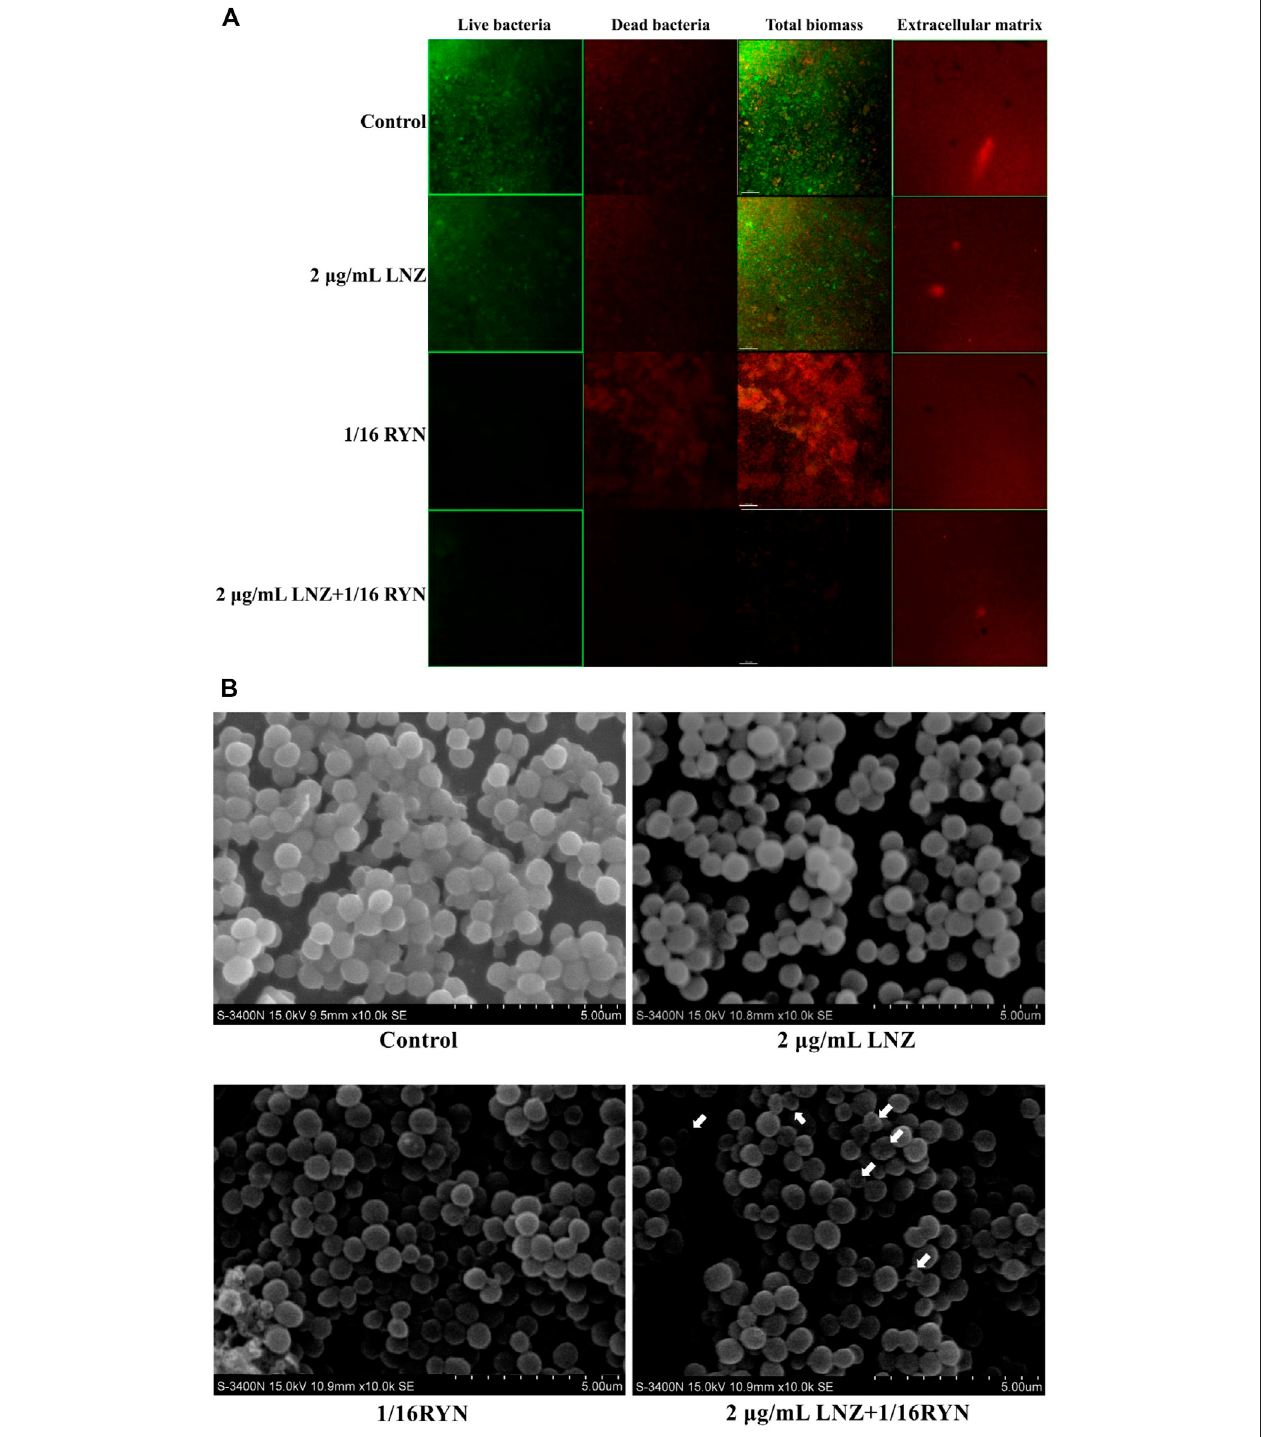
FIGURE 2 | Imaging results of the effects of LNZ and RYN on MRSA bio fi lm live and dead bacteria and extracellular matrix. (A) CLSM. In the fi rst three columns, green is the fl uorescence signal of living bacteria, and red is the fl uorescence signal of dead bacteria. The images show the inhibitory effect of LNZ and RYN on the maturity of MRSA bio fi lms, which is consistent with the results of the bio fi lm assay, and the combined group had a strong inhibitory effect on bio fi lms. There was no signi fi cant difference among the four groups in the extracellular matrix of the fourth column. The scale bar in images represents 150 µm. (B) SEM. In the mature stage ofaMRSAbio fi lmswithoutdrugintervention(control group), MRSAgrewinclumpsand thestructure ofthecellarrangementwascompact.Inthemature stageof MRSA bio fi lms treated with 2 μ g/ml LNZ and 1/16RYN, the structure of the cell arrangement was slightly loose. Combined 2 μ g/ml LNZ+1/16RYN intervention in the mature stage of a MRSA bio fi lm resulted in a loose cell arrangement structure, a different cell size, and an empty shell. Original magni fi cation: × 10000.